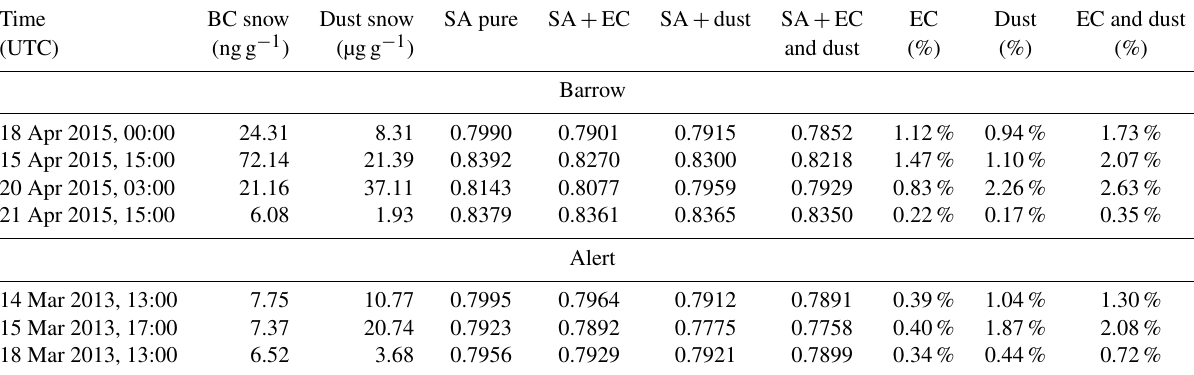
Table 4. Simulated changes in albedo due to dust, elemental carbon, and combination of dust and elemental carbon (SA represents the simulated surface albedo of pure snow). Time BC snow Dust snow SA pure SA + EC SA + dust SA + EC EC Dust EC and dust (UTC) (ngg − 1 ) (µgg − 1 ) and dust (%) (%) (%)